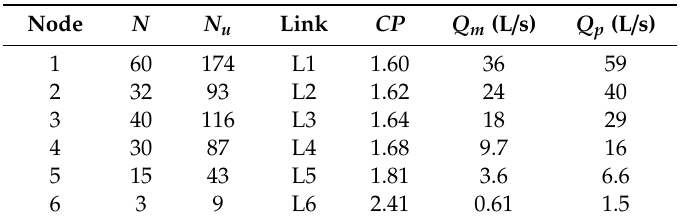
Figure 10. Sketch of a schematic mainline with six nodes serving di ff erent groups of households. Table 3. Example